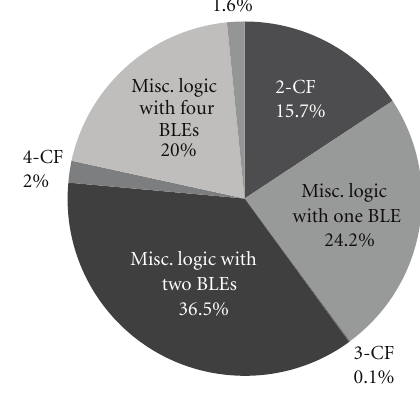
Figure 15: Ratio of Misc. Logic (five OpenCores benchmarks).